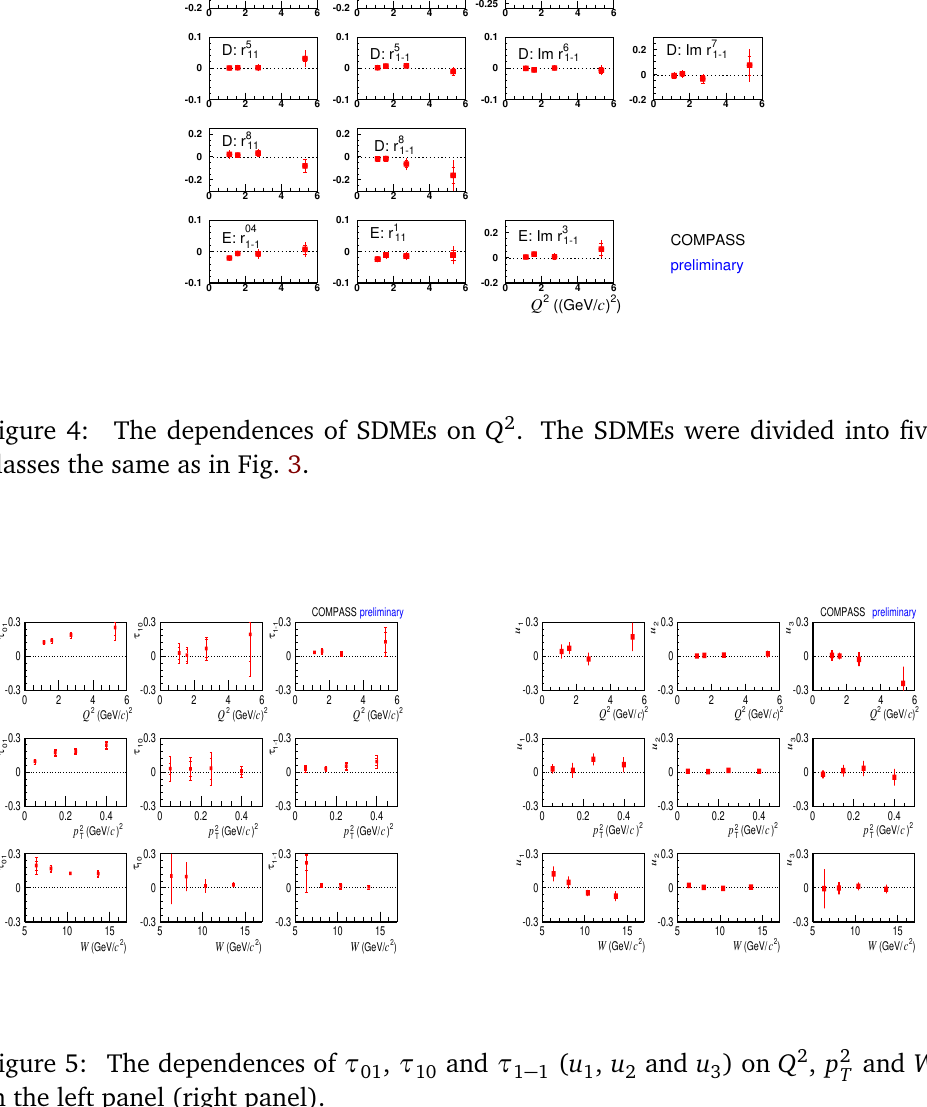
, τ and τ ( u , u and u ) on Q 2 , p 2 01 10 1 − 1 1 2 3